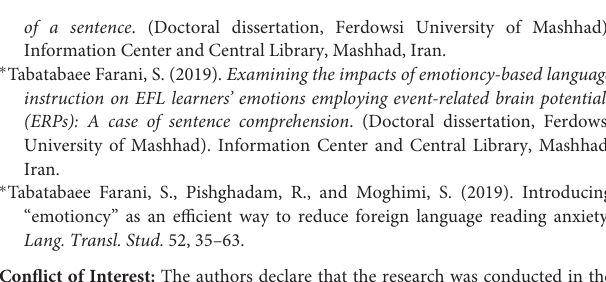
of a sentence . (Doctoral dissertation, Ferdowsi University of Mashhad). Information Center and Central Library, Mashhad, Iran. ∗ Tabatabaee Farani, S. (2019). Examining the impacts of emotioncy-based language instruction on EFL learners’ emotions employing event-related brain potentials (ERPs): A case of sentence comprehension . (Doctoral dissertation, Ferdowsi University of Mashhad). Information Center and Central Library, Mashhad, Iran. ∗ Tabatabaee Farani, S., Pishghadam, R., and Moghimi, S. (2019). Introducing “emotioncy” as an efficient way to reduce foreign language reading anxiety. Lang. Transl. Stud. 52, 35–63. Conflict of Interest: The authors declare that the research was conducted in the absence of any commercial or financial relationships that could be construed as a potential conflict of